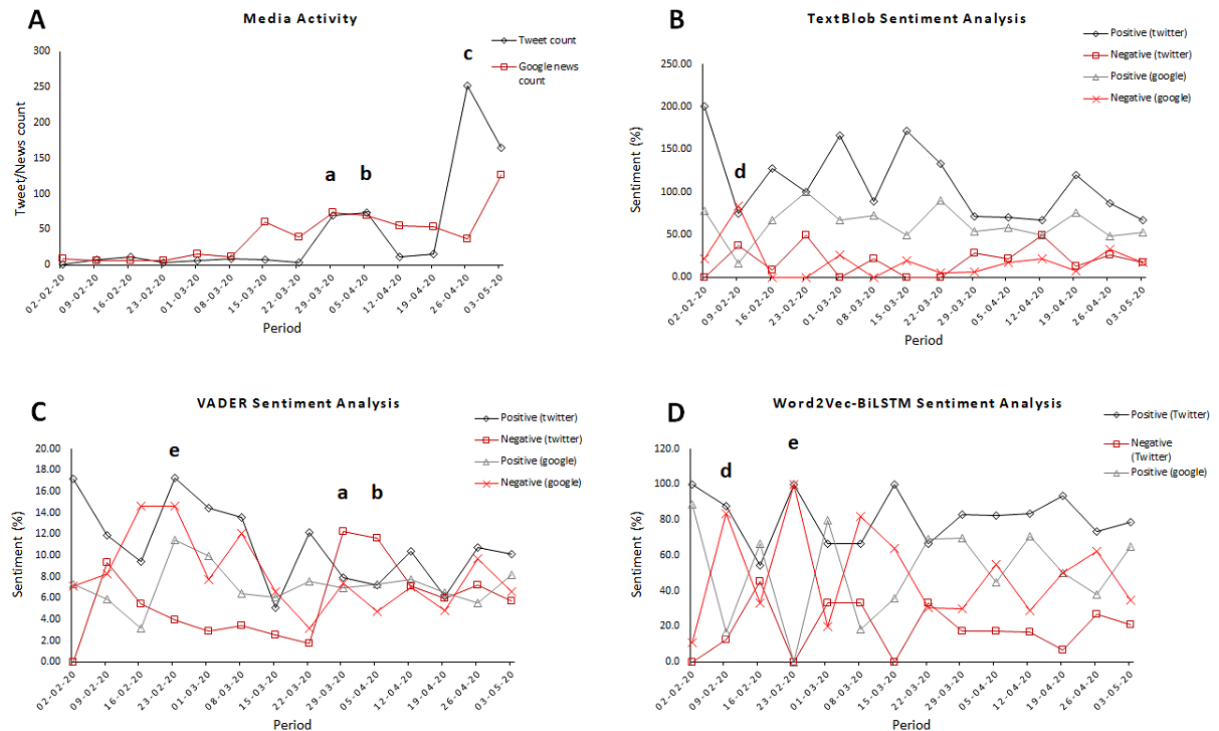
Figure 1. Media activity and sentiment analysis of tweets and Google News headlines and snippets between February 2 and May 5, 2020. (A) Media activity within the study period, (B) TextBlob sentiment analysis, (C) VADER sentiment analysis, and (D) Word2Vec-BiLSTM sentiment analysis.